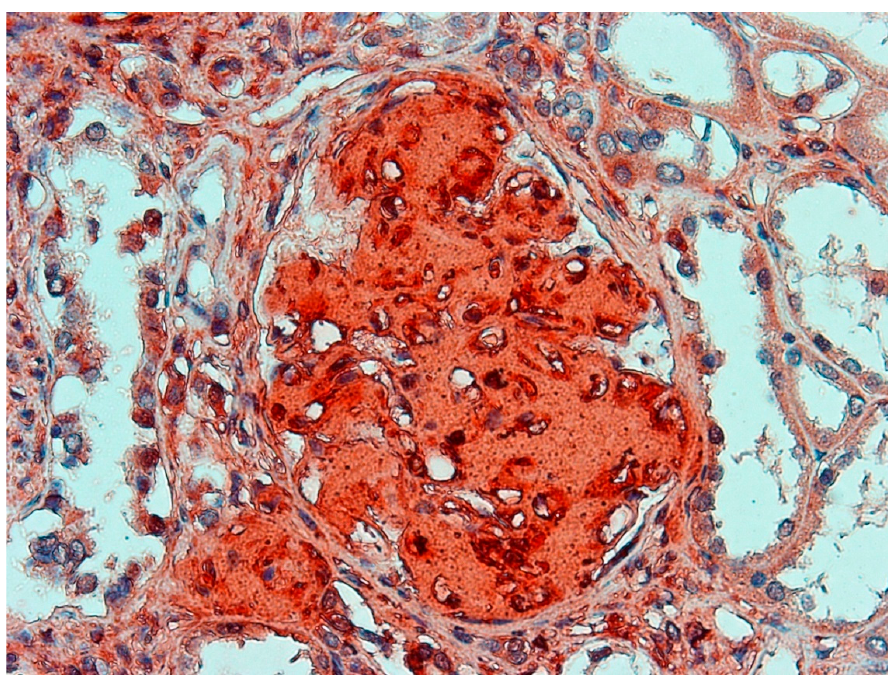
Figure 3. ( A ) Congo red positive deposits in glomerulus of the kidney. Magnification × 200. ( B ) Birefringent particles in the glomerulus and focally in the interstitium presenting a green apple color after staining with Congo red and seen under polarized light (white arrows). Magnification × 200.